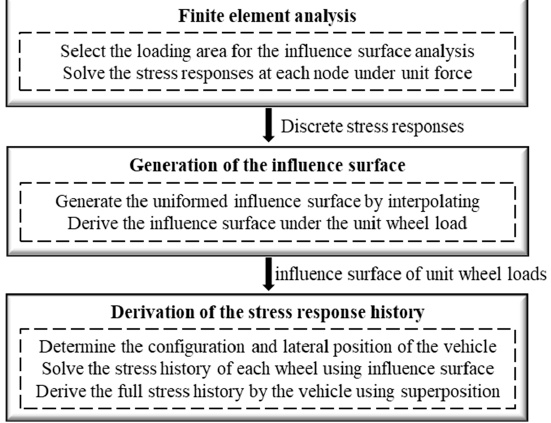
Figure 10. Flowchart of the influence surface-based stress analysis.